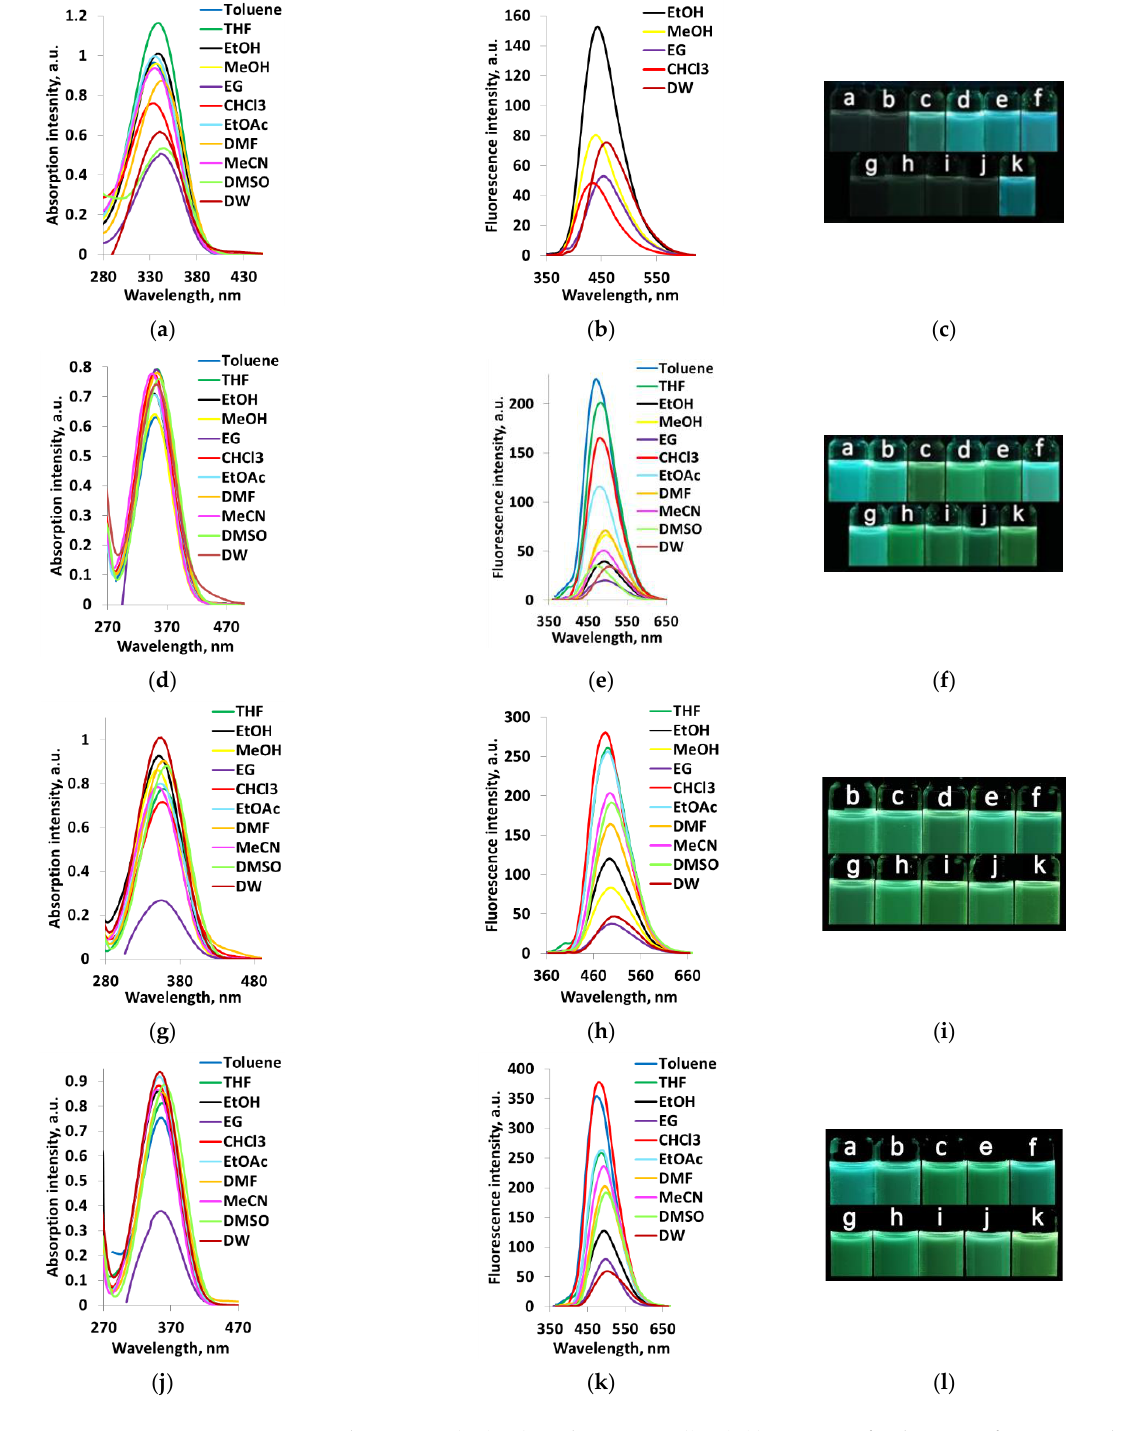
Figure 4. Absorption ( a , d , g , j ) and emission ( b , e , h , k ) spectra of solutions of compounds 10 ( a , b ), 11c ( d , e ), 13a ( g , h ), and 14b ( j , k ) in various solvents ( c , f , i , l ); photographs of solutions of compounds 10 ( c ), 11c ( f ), 13a ( i ), and 14b ( l ) under UV irradiation (λ = 365 nm). Solvents: a—toluene, b—THF, c— EtOH, d—MeOH, e—EG, f—CHCl 3 , g—EtOAc, h—MeCN, i—DMF, j—DMSO, k—DMSO–H 2 O ( v / v , 1:9) (c = 5 × 10 −5 M).